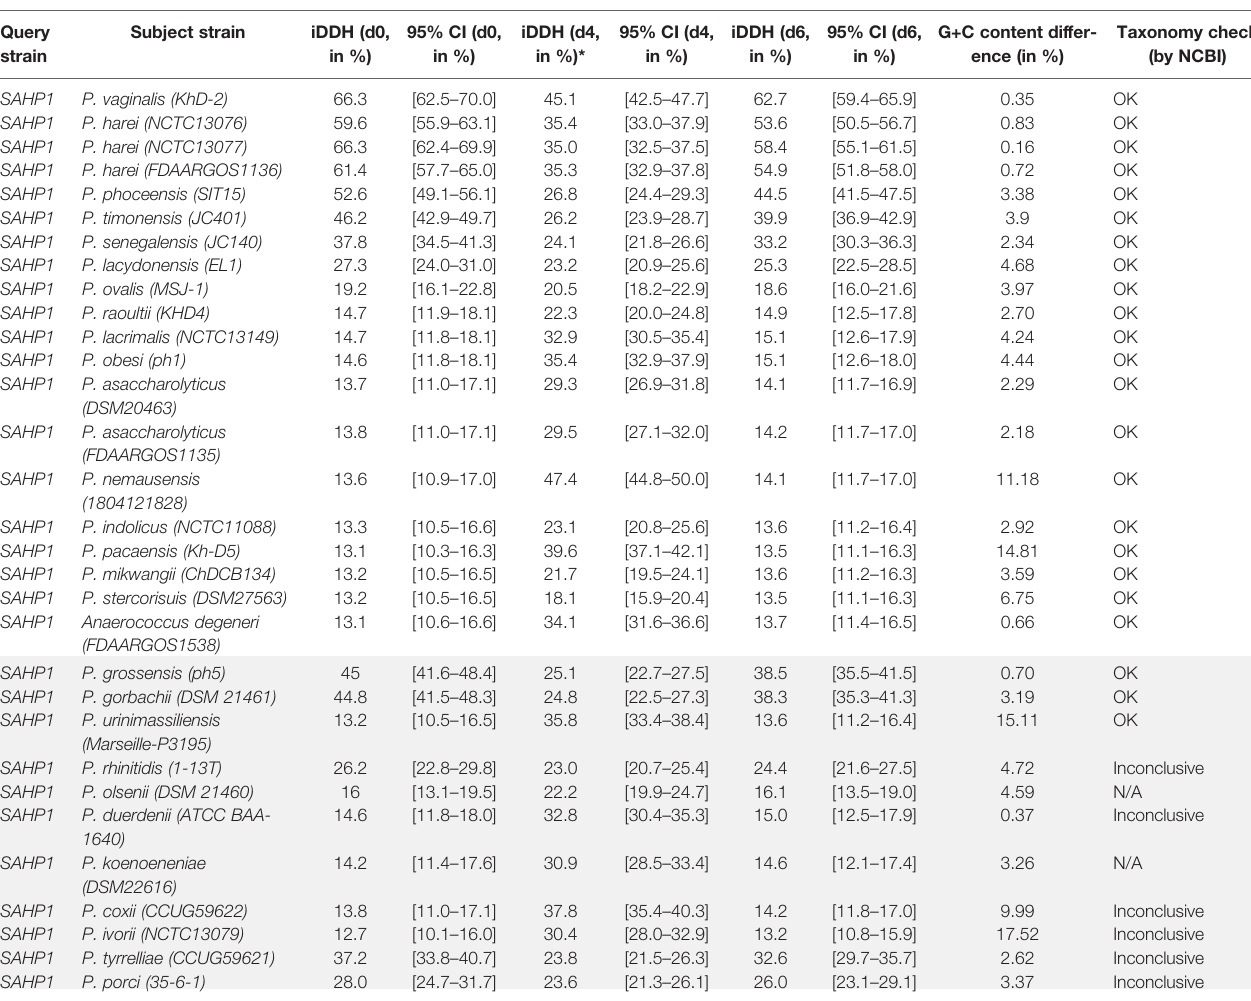
TABLE 1 | iDDH of SAHP1 with other reference